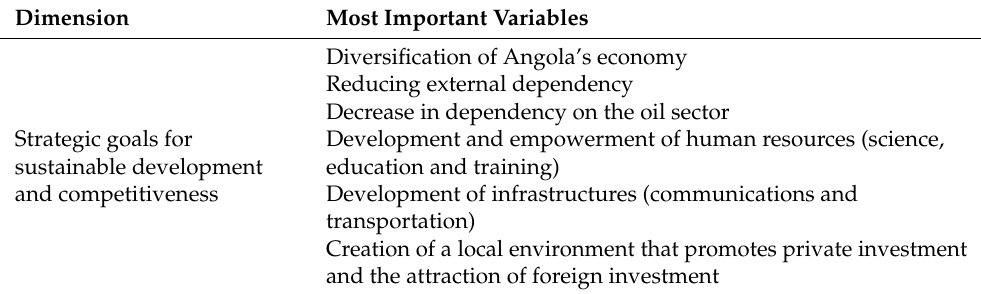
Table 1. Identification of dimensions and